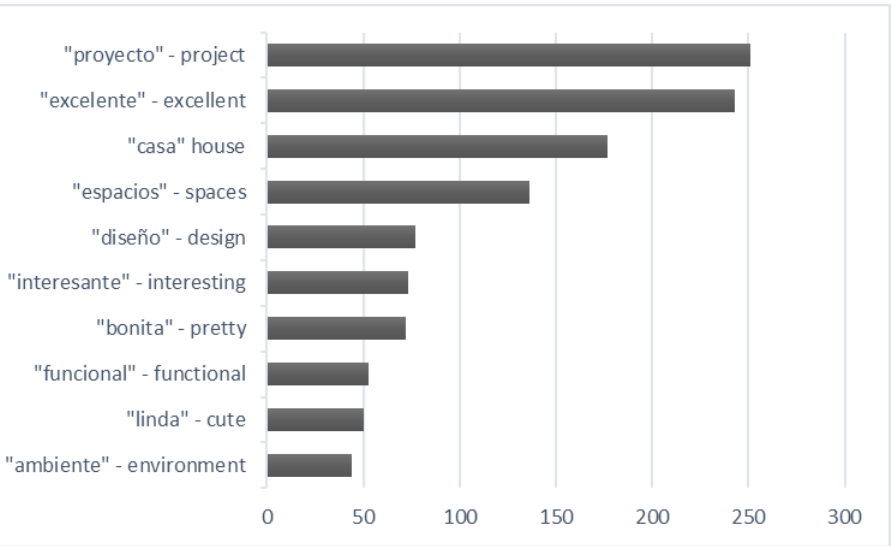
Int. J. Environ. Res. Public Health 2020 , 17 , x Figure 6. Terms most used by respondents. Figure 6. Terms most used by respondents.